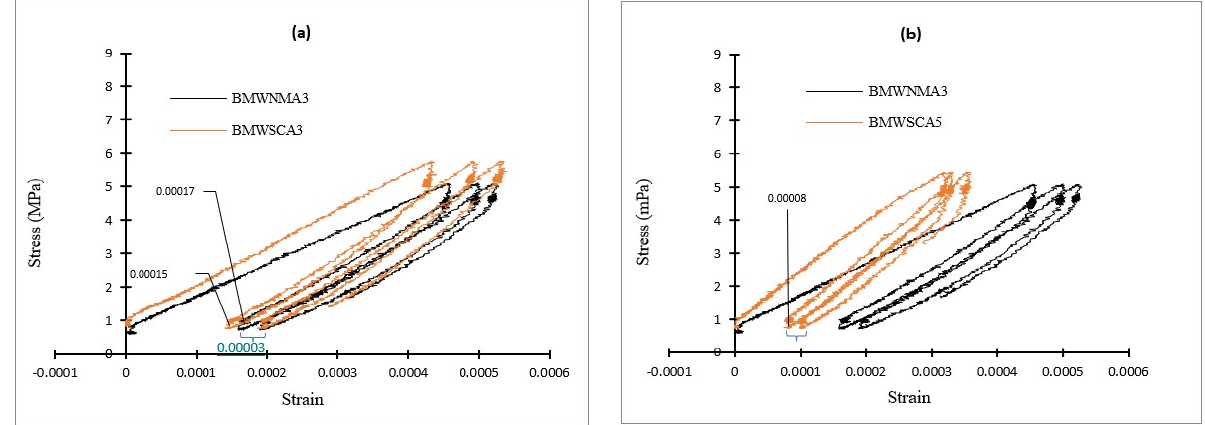
Figure 8. Stress-strain curves for masonry samples in the load cycle: ( a ) Comparison of BMWNMA3 and BMWSCA3; ( b ) Comparison of BMWNMA3 and BMWSCA5.